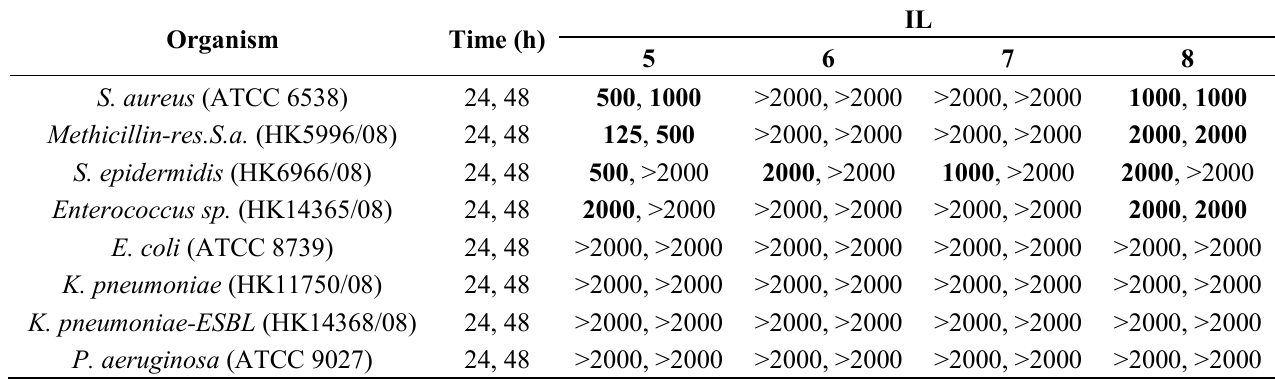
Table 2. MIC (μM, IC ) values obtained for dipeptidyl ILs 5 – 8 . 1 – 4 exhibited 95 MIC values > 2 mM and are not included in the